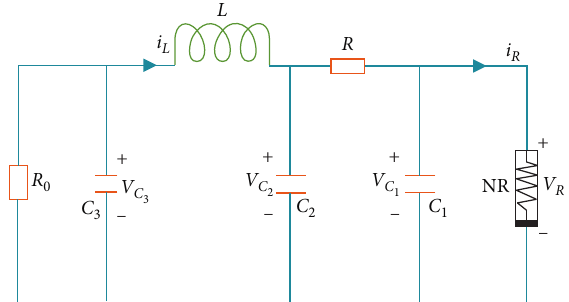
Figure 1: Modified fourth-order autonomous Chua’s chaotic